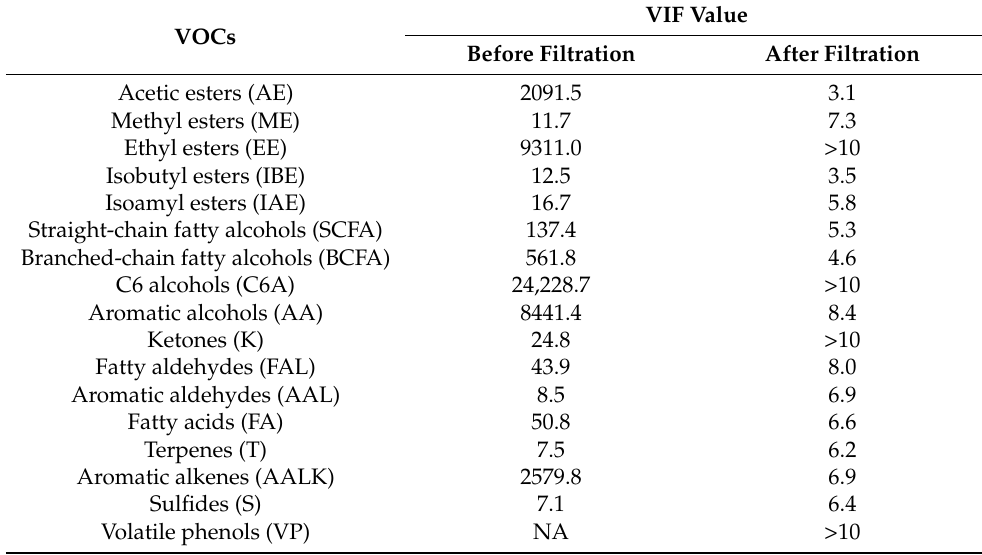
Table 2. VIF analyses of VOCs.